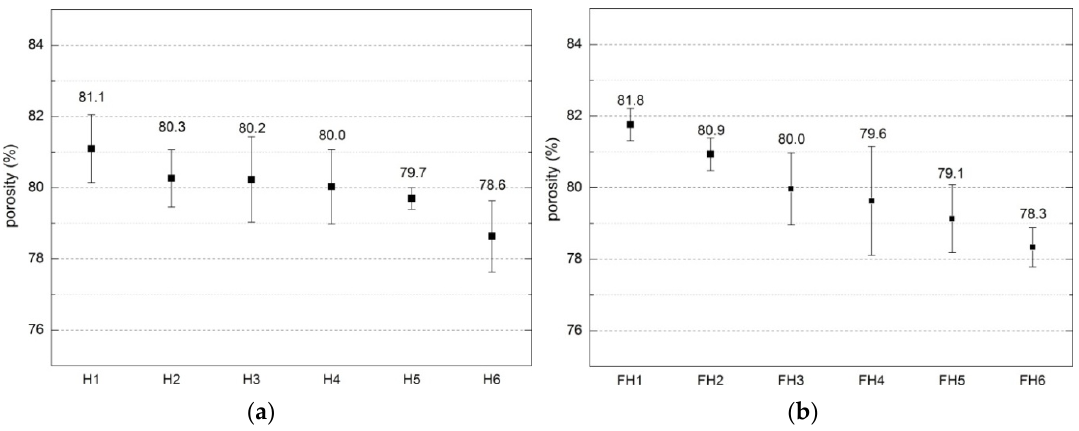
Figure 9. Total porosity of composites (error bars mean standard deviations of porosity): ( a ) Series 1, ( b ) Series 2.